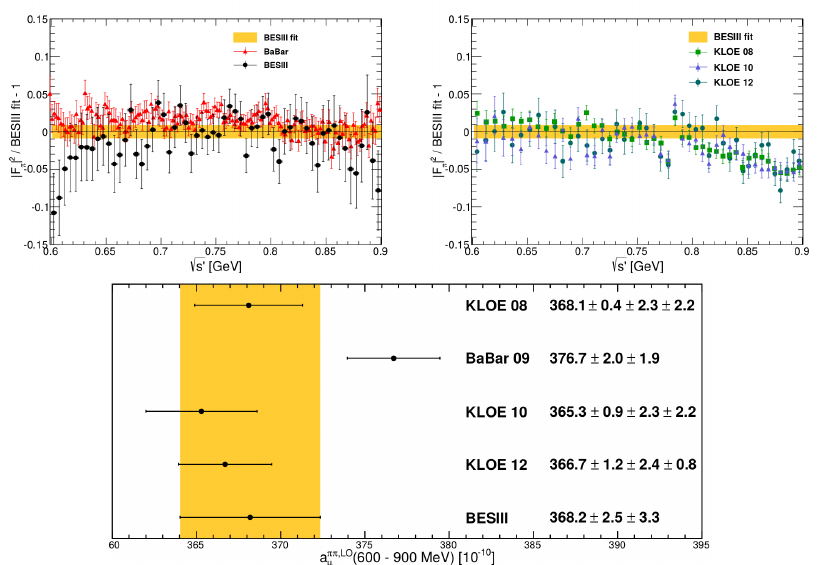
Figure 2. Comparison of the fitted pion form factor from BESIII to BaBar (top left) and KLOE (top right). Comparison of the results for a ππ, LO µ (600 − 900 MeV ) between KLOE, BaBar and BESIII (bottom). The errors bars include statistical and systematic errors.